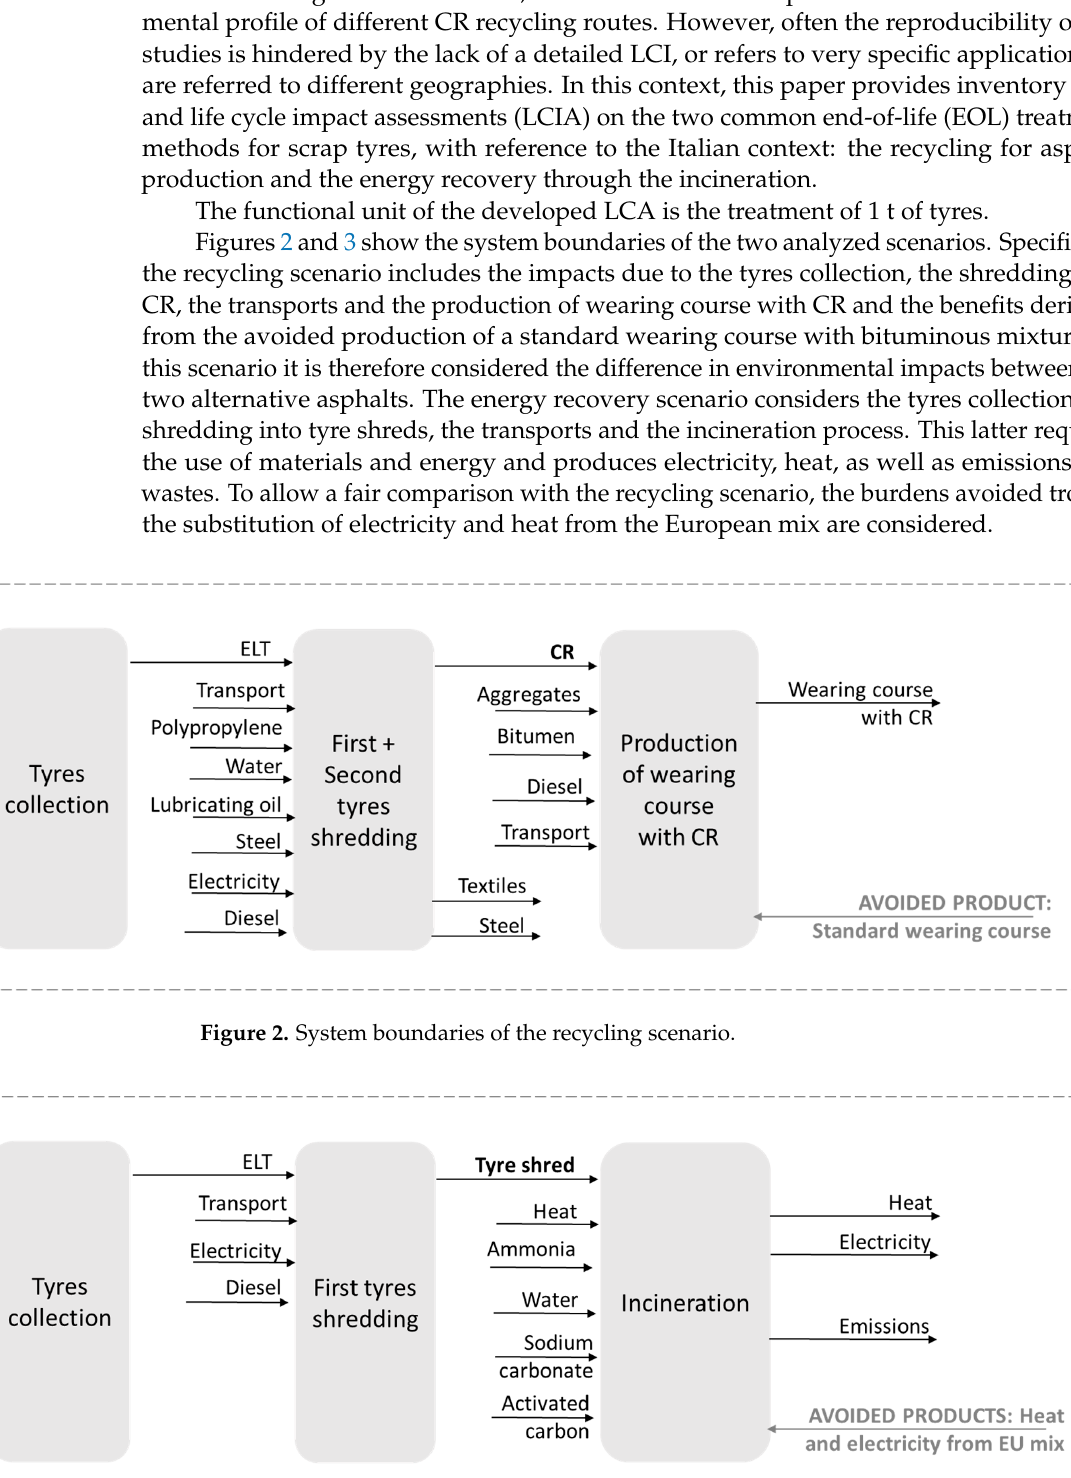
Figure 1. Flow chart of the two analysed scenarios for the ELTs.